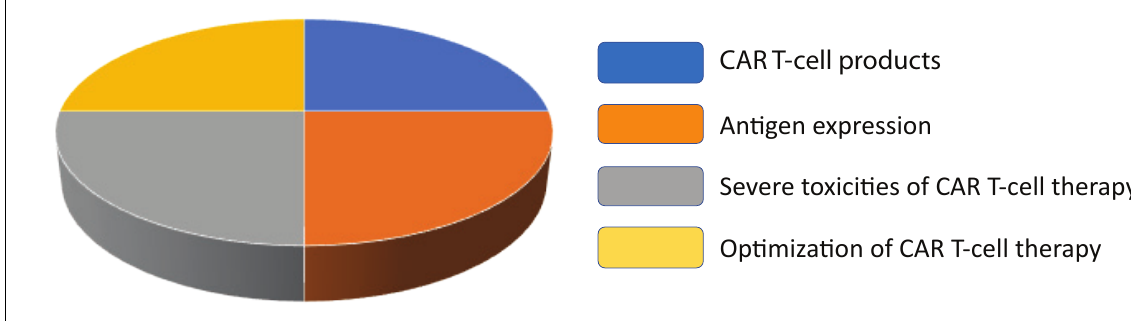
Figure 6. Possible reasons for the failure to sustain remission after CAR T-cell therapies. (1) CAR T-cell products: CAR T-cell product from some patients may not be successfully manufactured due to T cell problems (e.g., autologous T cells obtained from the patients after chemotherapy), or the produced CAR T-cells may not expand adequately either during in vitro culture or after infusion in vivo. Limited persistence of CAR T-cells in other patients is a potential mechanism for disease recurrence. (2). Antigen expression: The absence or downregulation of antigens on the tumor cell surfaces, allows antigen escape as a mechanism of resistance to CAR T-cell therapy. (3). Severe toxicities of CAR T-cell therapy: The fatal toxicity of CAR T-cell therapy (e.g., CRS and/or neurotoxicity) prevents a small percentage of patients benefit from the potential therapeutic of CAR T-cell therapy. (4). Optimization of CAR T-cell therapy in clinical application: For the treatment of the patients with pediatric lymphoma, and solid tumors, CAR T- cell therapy need to be further optimized.